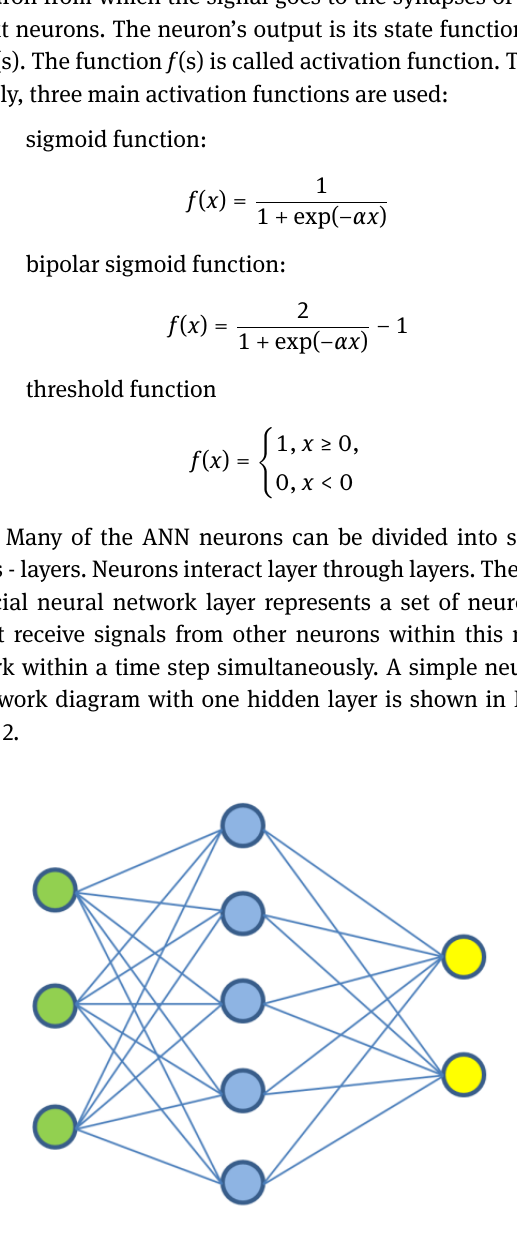
Figure 2. A simple neural network diagram with one hidden layer.